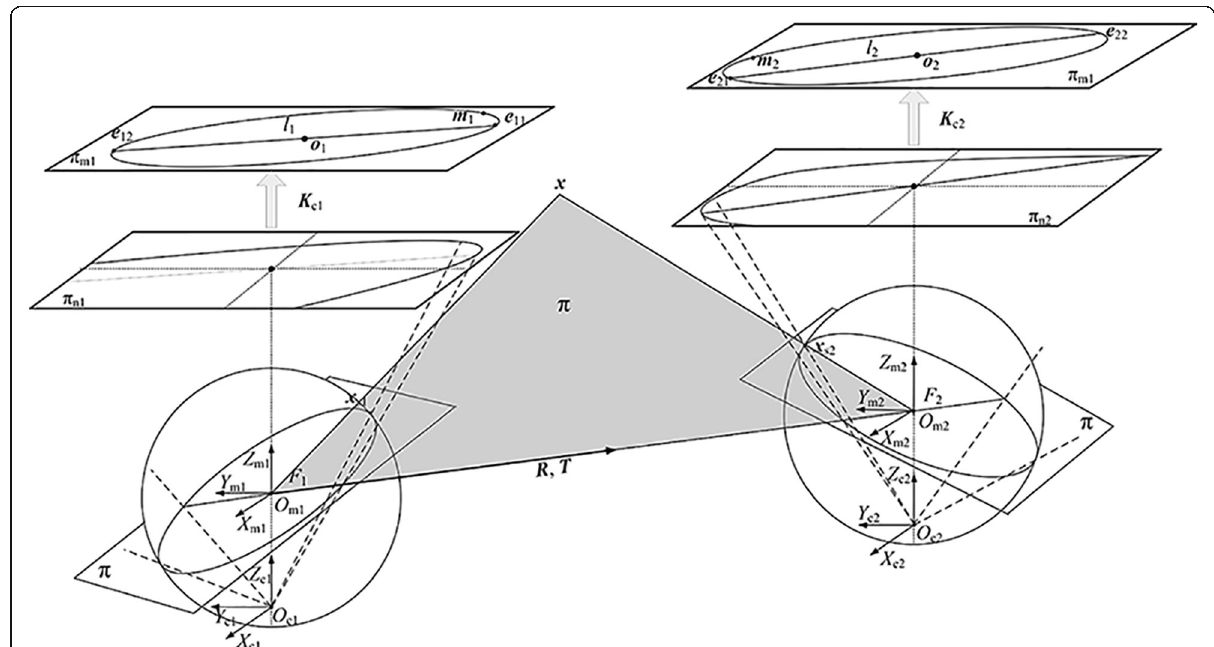
Fig. 5 Epipolar geometry model of a general omnidirectional, stereo vision system